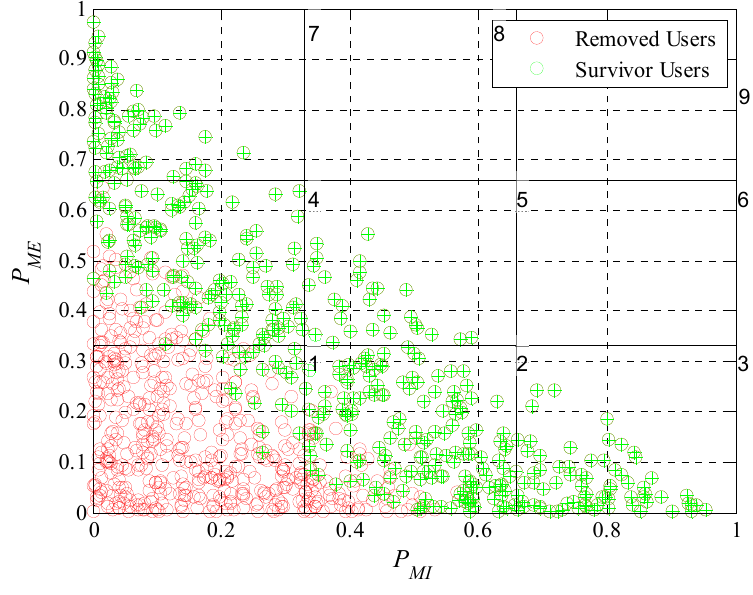
Figure 19. Graphical representation of user motivation levels on a Cartesian plane divided into subgroups when r desired = 0.6 .